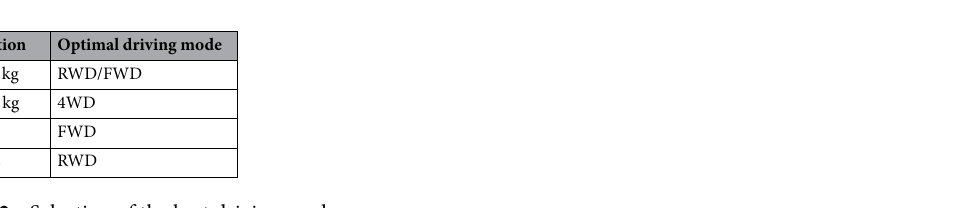
Table 2. Selection of the best driving